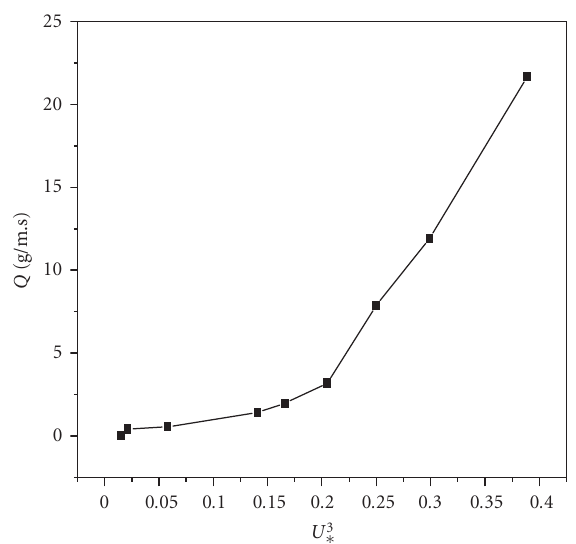
Figure 9: Saltation transport rate versus cube of friction